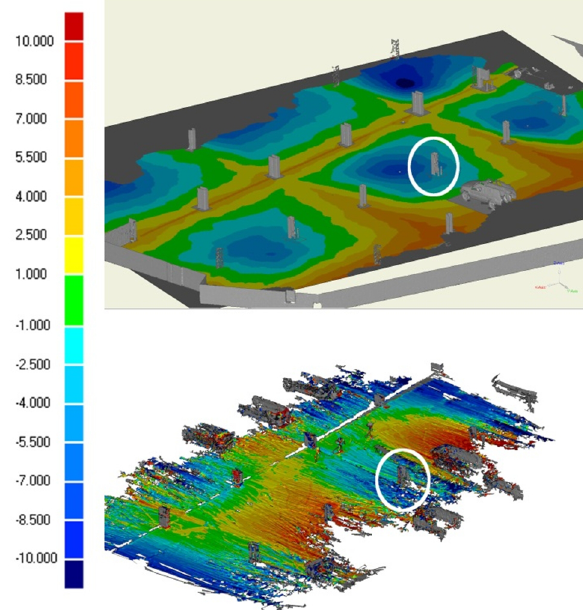
Figure 9. Top: Contour plot from the reference TLS point cloud displays the floor height profile (in cm). The largest displacements from a virtual horizontal plane are shown with deep blue (descent) and orange (ascent). Bottom: The difference of triangulated surface models between the straight trajectory estimate and the corrected VILMA data. Both plots use the same units that are in cm, and display one pillar circled with white color to guide the